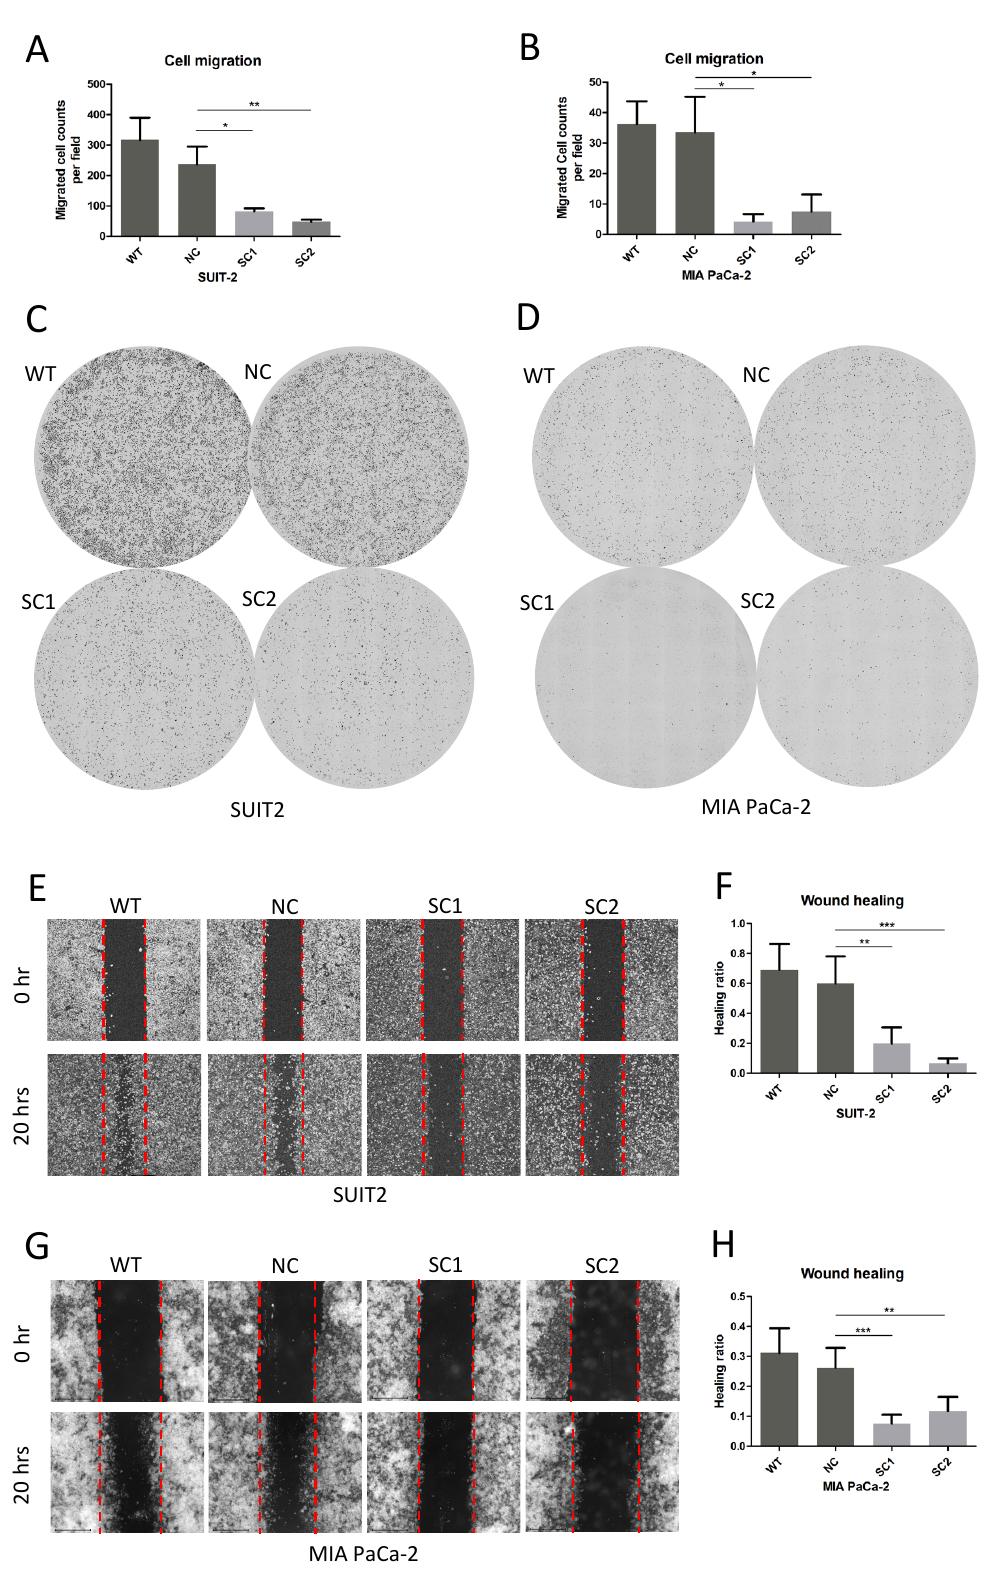
Figure 4. Knockout of PCSK6 inhibited cell migration. ( A , C ) Migration assay and counts of migrated cells in SUIT-SCs and controls. ( B , D ) Migration assay and counts of migrated cells in MIA-SCs and controls. ( E , F ) Wound-healing assay results and healing ratio in SUIT-SCs and controls. ( G , H ) Wound- healing assay results and healing ratio in MIA-SCs and